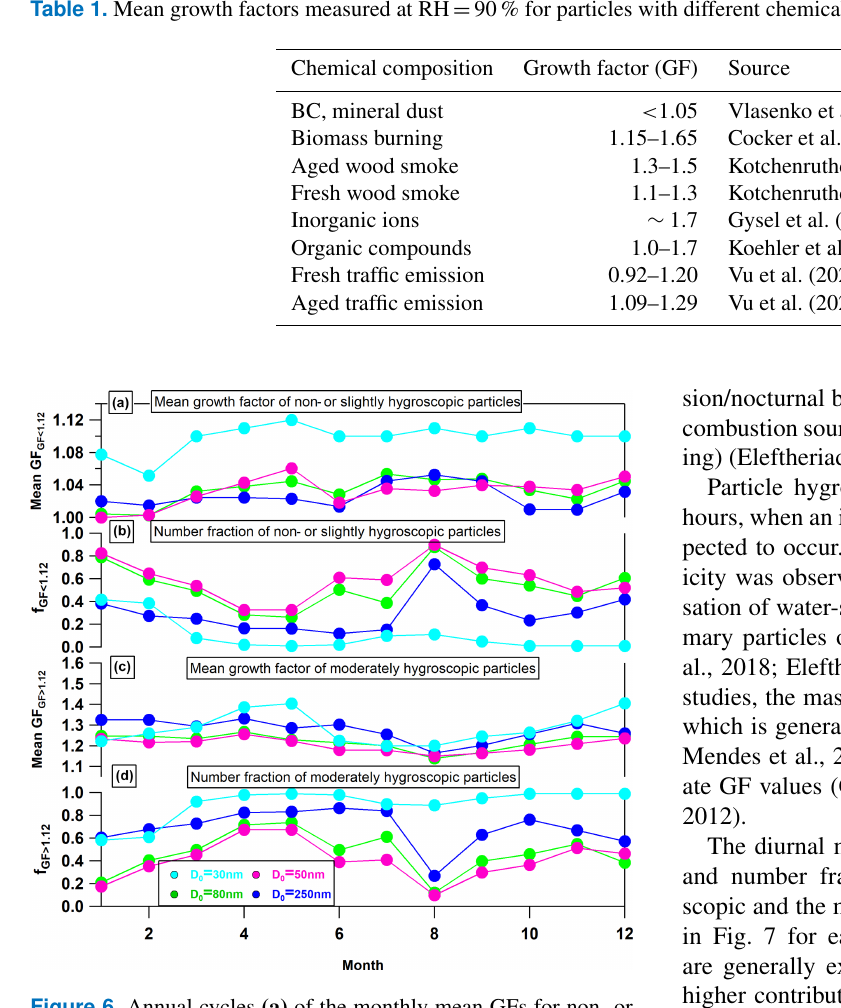
Figure 6. Annual cycles (a) of the monthly mean GFs for non- or slightly hygroscopic particles at 90% RH, (b) of the number frac- tion of non- and/or slightly hygroscopic particles at 90% RH, (c) of the monthly mean GFs for moderately hygroscopic particles at 90% RH, and (d) of number fraction of moderately hygroscopic particles for different particle